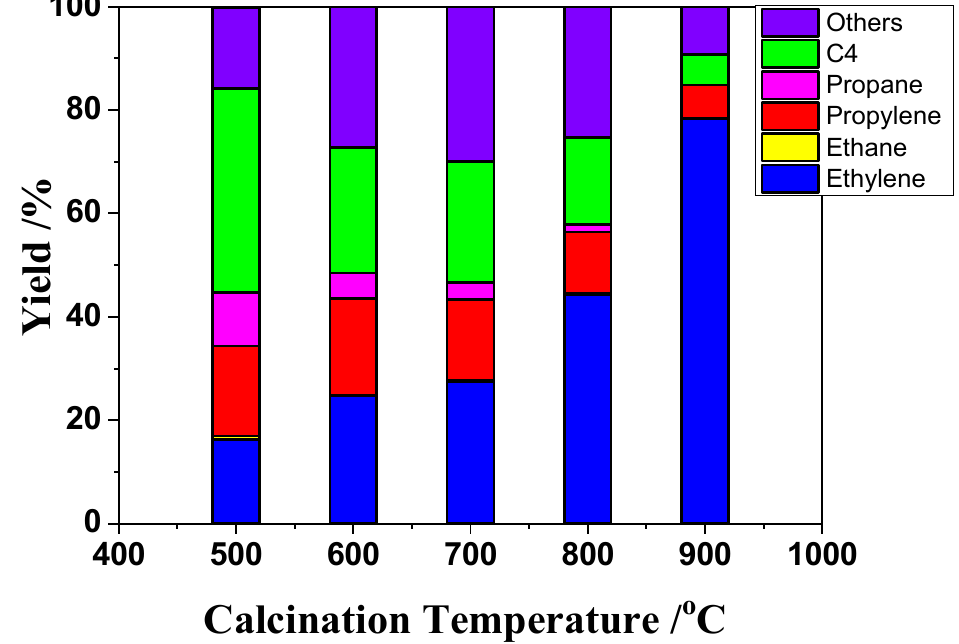
Figure 2. Production distributions over H-ZSM-5(80) catalysts as a function of calcination temperature. Temperature, 400 °C; EtOH concentration, 50%; W/F = 0.0025 g/cm 3 ·min − 1 .